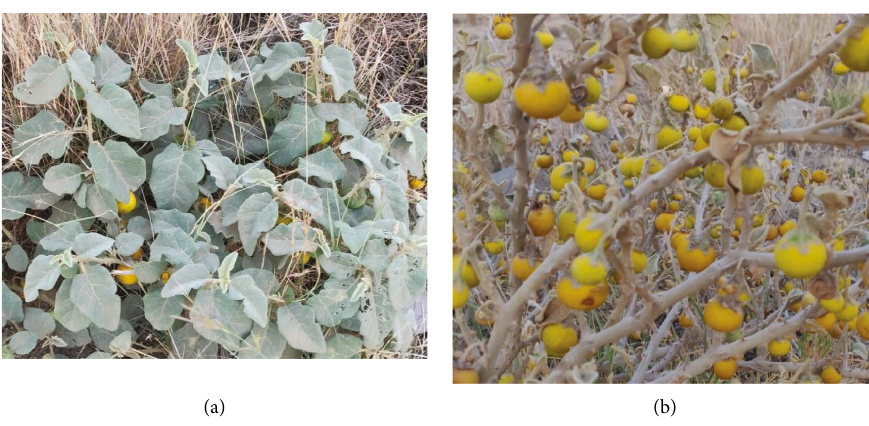
Figure 1: Leaves (a) and fruits (b) of Solanum incanum , Asir Region, Abha, Saudi